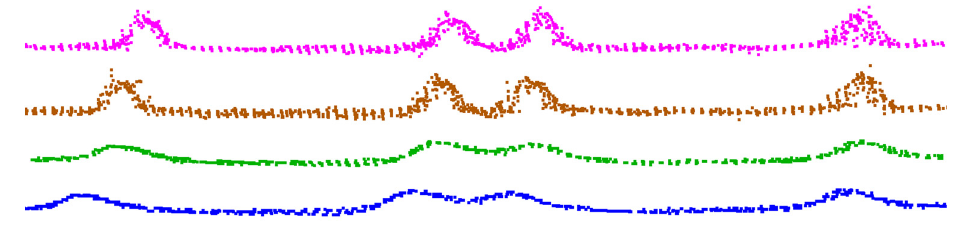
Figure 7. Profiles of the different point clouds perpendicular to the rail axis - profile position in the photo (top), point cloud profiles (bottom): P4D JPG80 (pink), P4D TIF (brown), PS JPG80 (green) and PS TIF (blue)